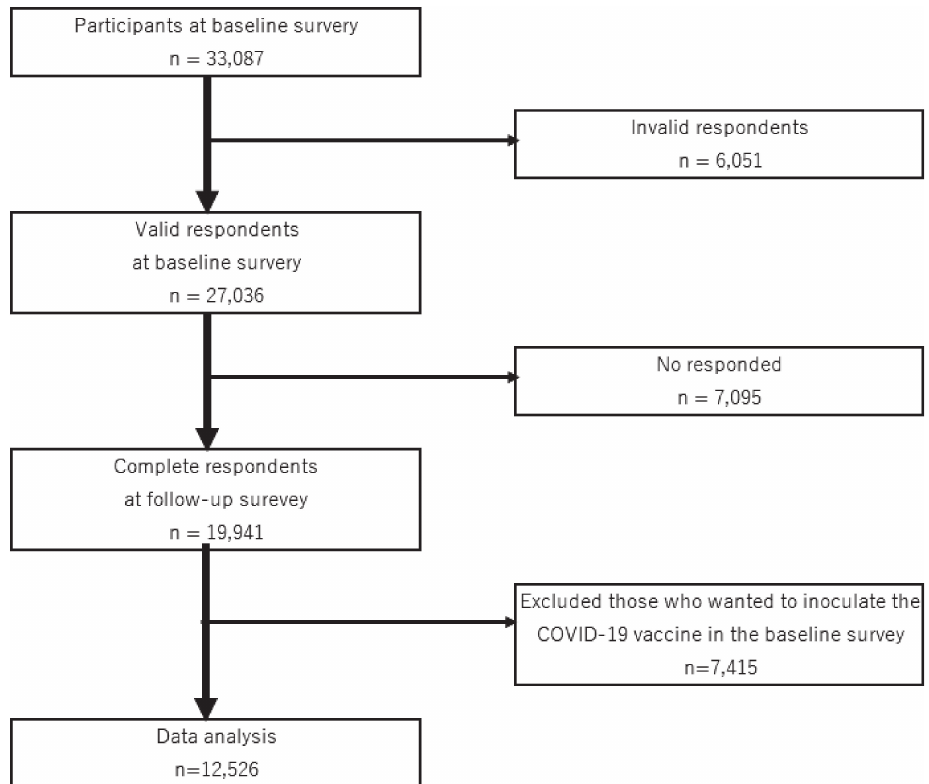
Fig. 1 Flow diagram of this